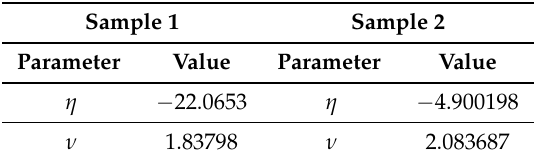
Table 2. Estimated parameters of O-U process for H s series.